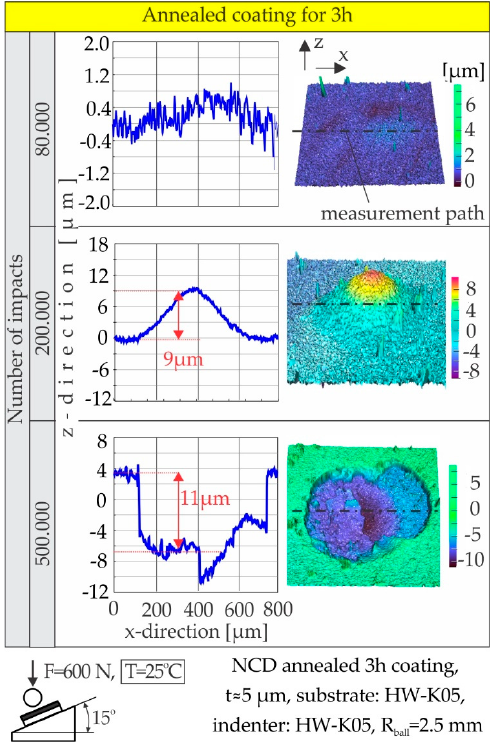
Figure 7. Impact test results on the as deposited nano-crystalline diamond (NCD) coated inserts at an impact load of 350 N after various number of impacts.